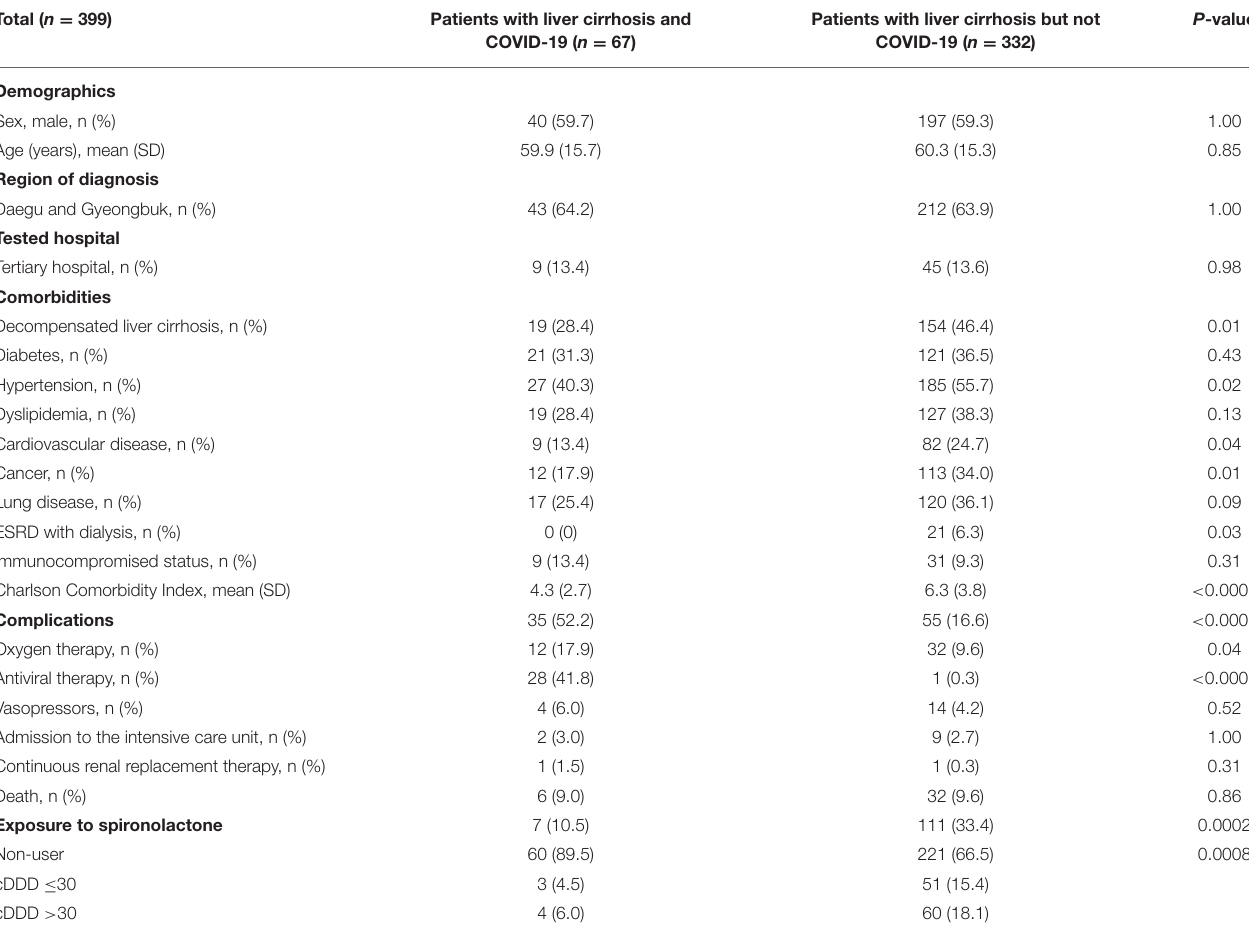
TABLE 1 | Baseline characteristics of patients with liver cirrhosis, according to COVID-19. Total ( n = 399) Patients with liver cirrhosis and